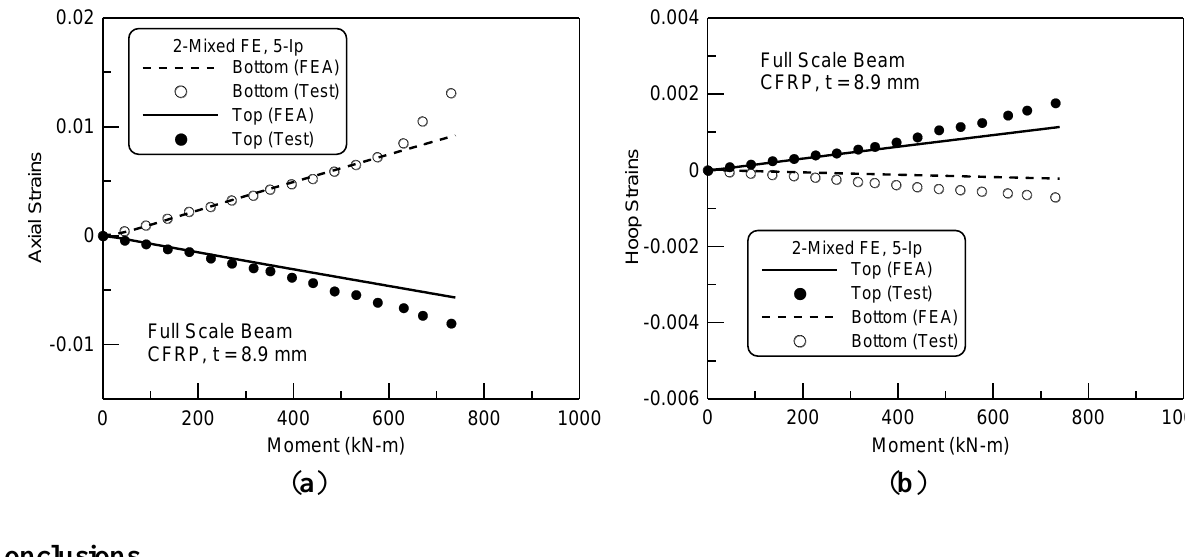
Figure 8. ( a ) Axial strains and bending moment relationship at center span; and ( b ) hoop strains and bending moment relationship at center